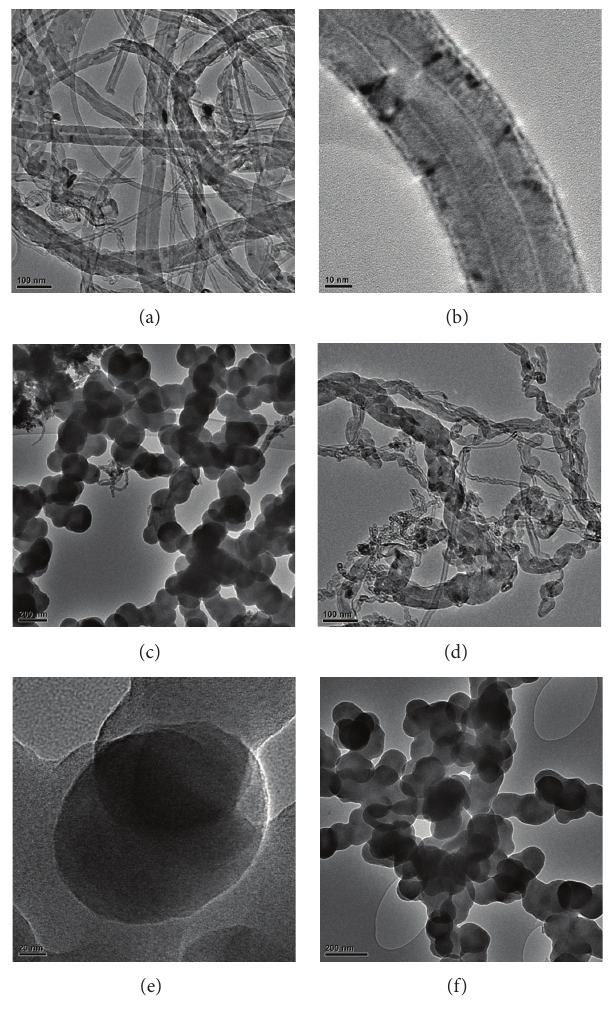
Figure 3: High-resolution transmission electron micrograph (HR TEM) of nanomaterial synthesized from Fe/Co supported on mag- nesium oxide ((a)–(c)) and Fe/Co supported on calcium carbonate